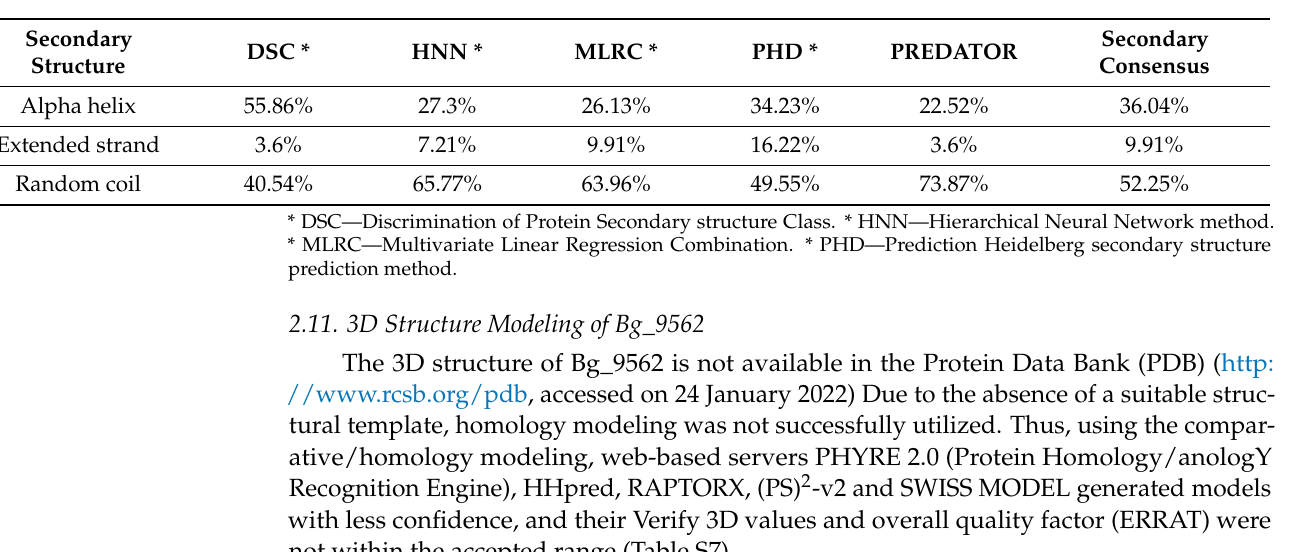
Table 3. Secondary structure of Bg_9562 predicted using NPS@